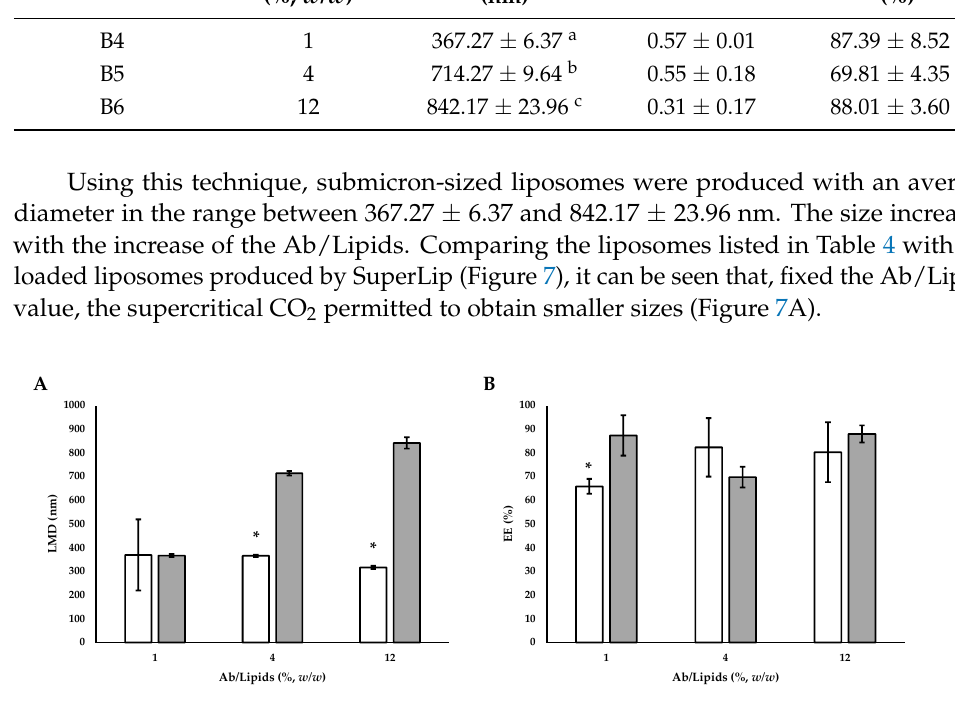
Figure 7. ( A ) Comparative analysis of LMD and ( B ) EE between Ab-loaded liposomes prepared by SuperLip process and those prepared by thin-layer hydration method. The symbol (*) refers to statistically significant differences among results ( p < 0.05, ANOVA with Tukey’s HSD post-hoc multiple comparison test).